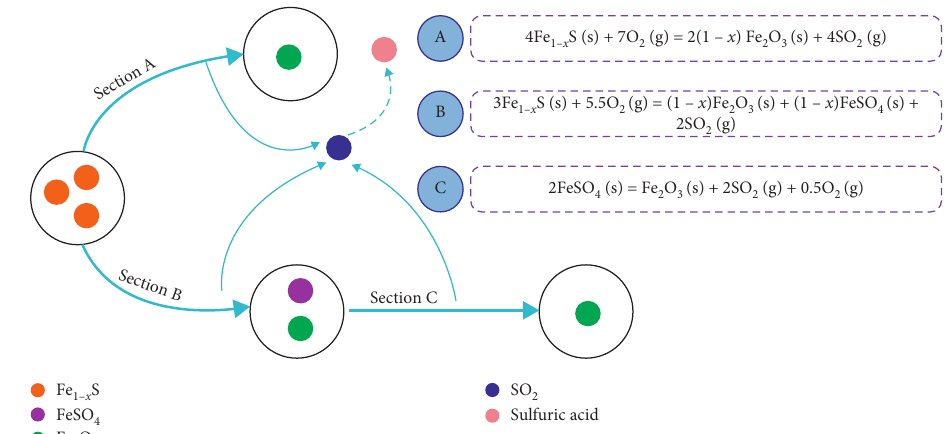
Figure 13: Schematic of the mechanism of sulfur release and phase transition.